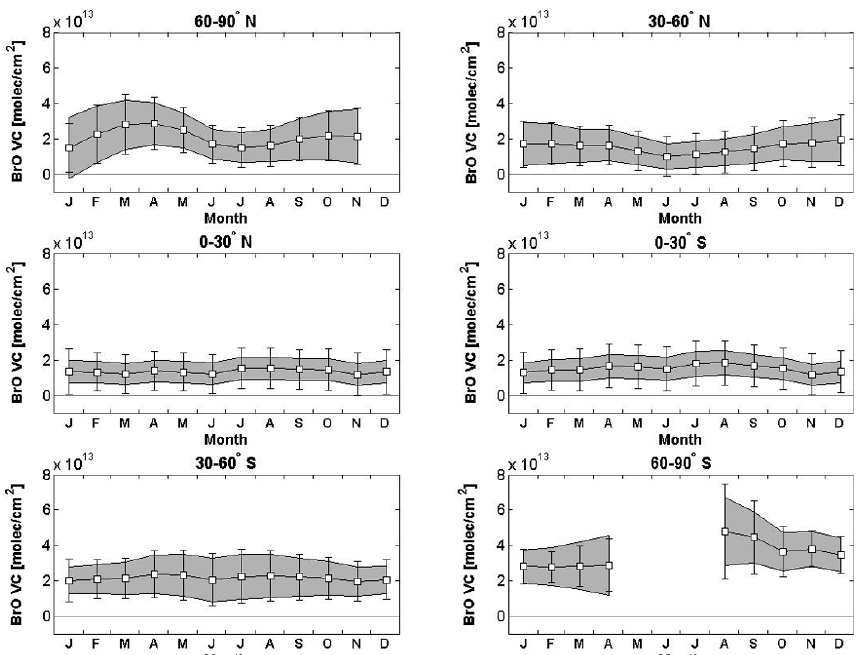
Fig. 14. Zonal mean of tropospheric BrO vertical columns as a function of time (monthly averages). The grey-dashed area indicates the total error on the tropospheric BrO vertical columns (see text). The error bars correspond to 1-sigma standard deviation of the data around the mean. The data used are from 2007 to 2008, and solar zenith angles lower than 80 ◦